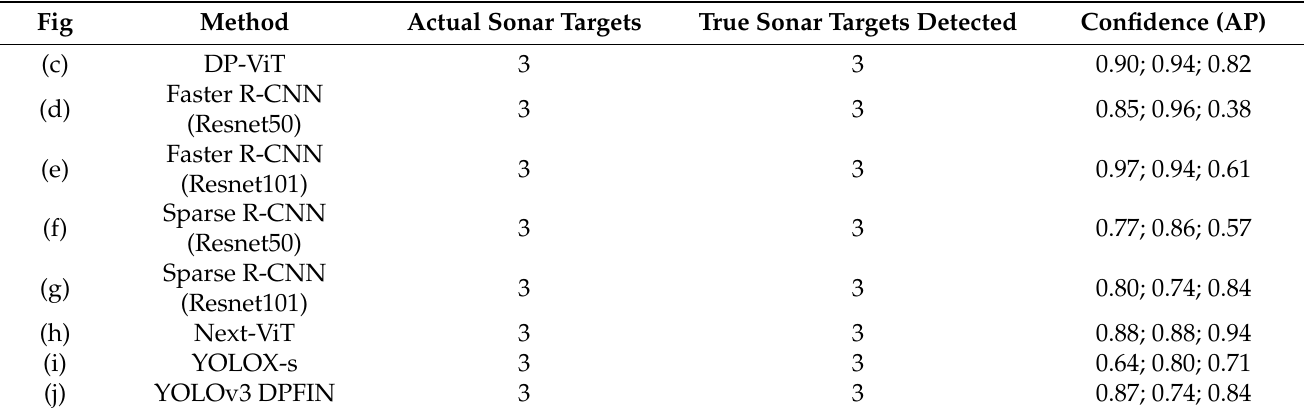
Figure 6. Comparison of DP-ViT and other methods in forward-look sonar dataset ( a ) real sonar image ( b ) true sonar image target ( c ) our method: DP-ViT ( d ) Faster R-CNN (Resnet50) ( e ) Faster R- CNN (Resnet101) ( f ) Sparse R-CNN (resnet50) ( g ) Sparse RCNN (resnet101) ( h ) Next ViT ( i ) YOLOX-s ( j ) YOLOv3 DPFIN. Table 1. Figure 6 Schematic test